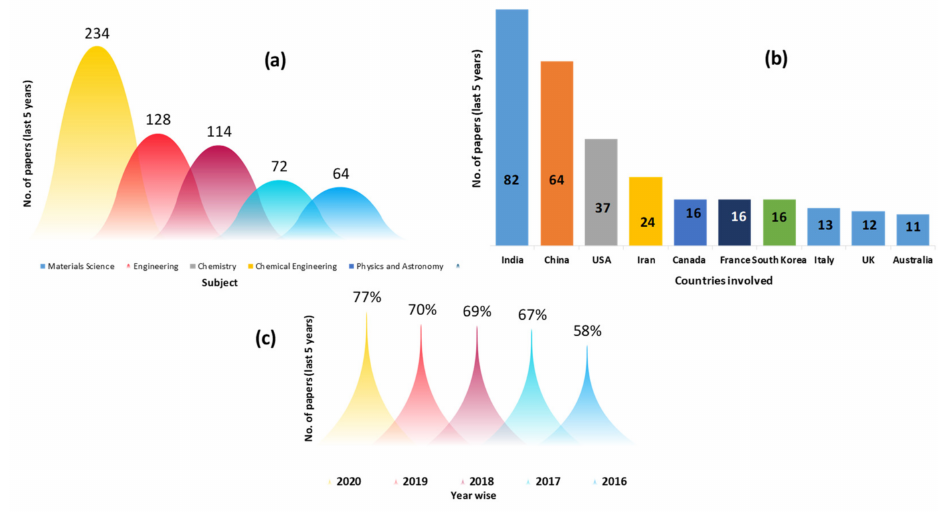
Figure 1. Scopus data for the last five years by typing the keywords “bio”, “nano”, and “polymer composites”. One can see the growing interest in terms of the number of publications by ( a ) subject ( b ) countries, ( c ) percentage of papers by